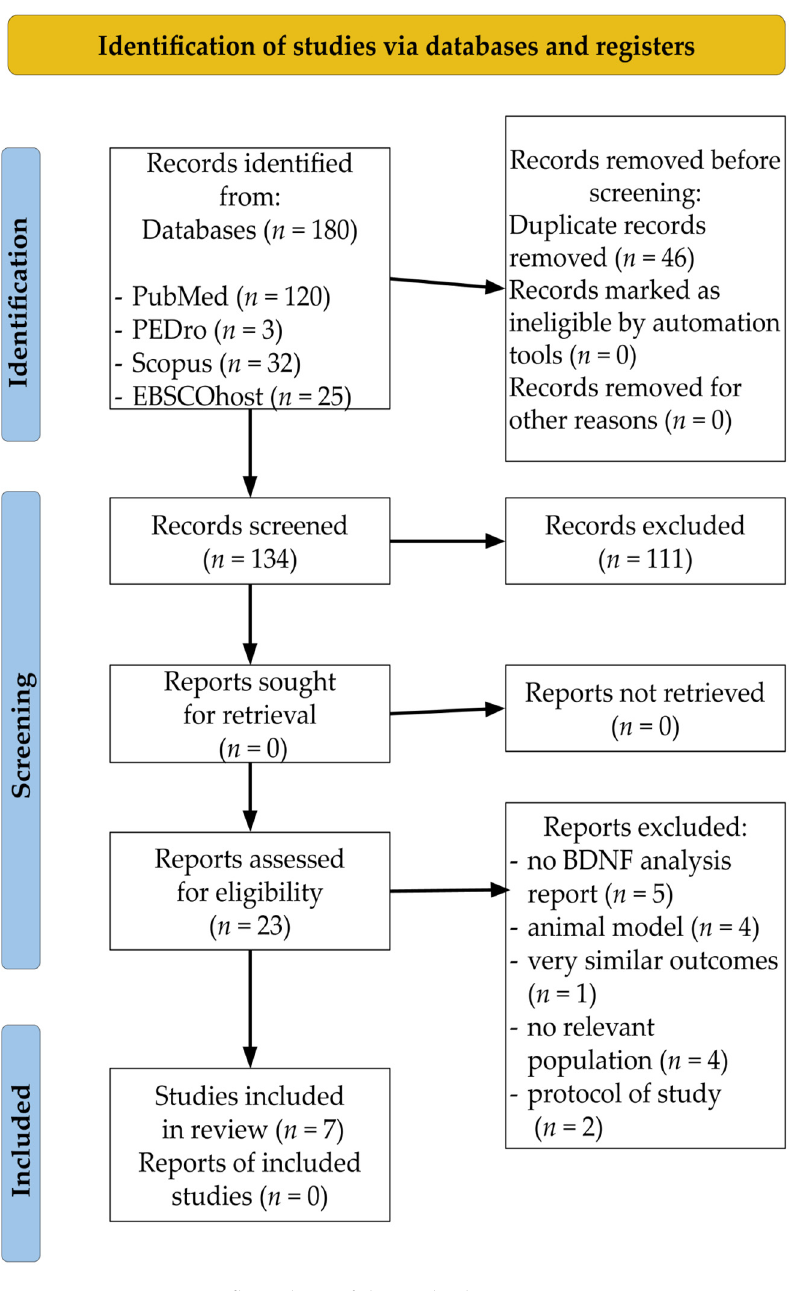
Figure 1. PRISMA 2020 flow chart of the trial selection process.